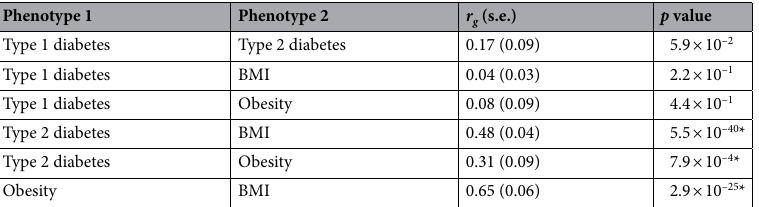
Table 2. Genetic correlation estimates between T1D, T2D, body mass index and obesity in people of European ancestry. r g , genetic correlation estimate; s.e., standard error; p value, Bonferroni corrected p values; *significant corrected p values. Variant heritability estimates (h2; s.e.) are: T1D (0.0046; 9e-04), T2D (0.01; 9e-04), BMI (0.2565; 0.0081), Obesity (0.0061;